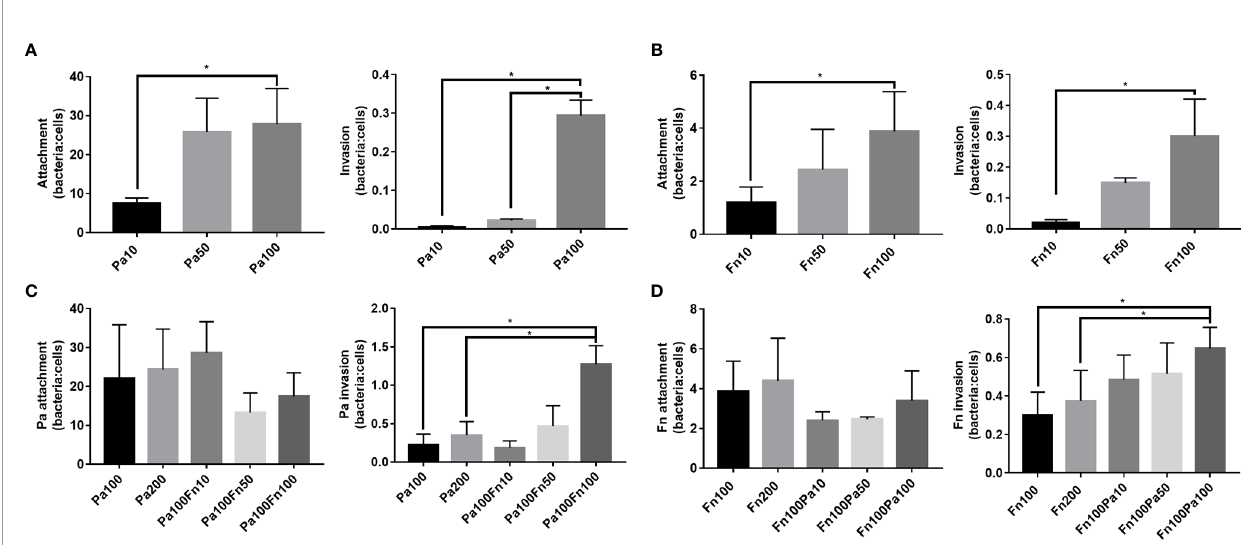
FIGURE 2 | The adherence and invasion of P. aeruginosa and F. nucleatum to pulmonary epithelial cells. (A) The attachment and invasion of P. aeruginosa to pulmonary epithelial cells. A549 cells were infected with different MOI (10, 50, 100) of P. aeruginosa . (B) The attachment and invasion of F. nucleatum to pulmonary epithelial cells. A549 cells were infected with different MOI (10, 50, 100) of F. nucleatum . (C) The effect of F. nucleatum on the attachment and invasion of P. aeruginosa . A549 cells were simultaneously infected with P. aeruginosa (MOI 100) and F. nucleatum (MOI 10, 50, 100), and the single P. aeruginosa infection groups (MOI 100, 200) were used as control. (D) The effect of P. aeruginosa on the attachment and invasion of F. nucleatum . A549 cells were simultaneously infected with F. nucleatum (MOI 100) and P. aeruginosa (MOI 10, 50, 100), and the single F. nucleatum infection groups (MOI 100, 200) were used as control. * P < 0.05, statistics were achieved by analysis of variance followed by Sidak ’ s multiple comparisons test. Pa, P. aeruginosa ; Fn, F. nucleatum